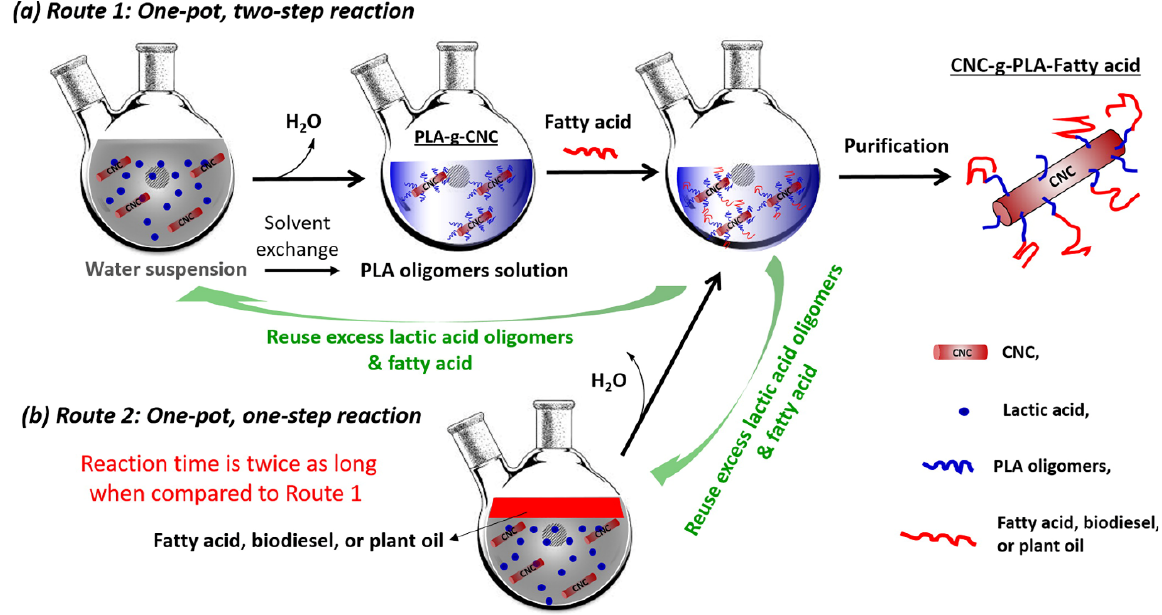
Figure 8: Summary of methodology used for hydrophobized CNC using a fatty acid. Reproduced from [79] copyright 2016 American Chemi- cal